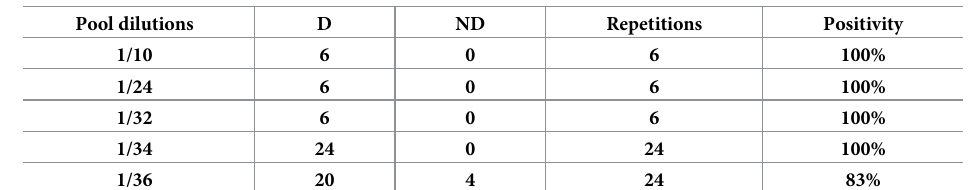
Table 2. Maximum grouping determination.